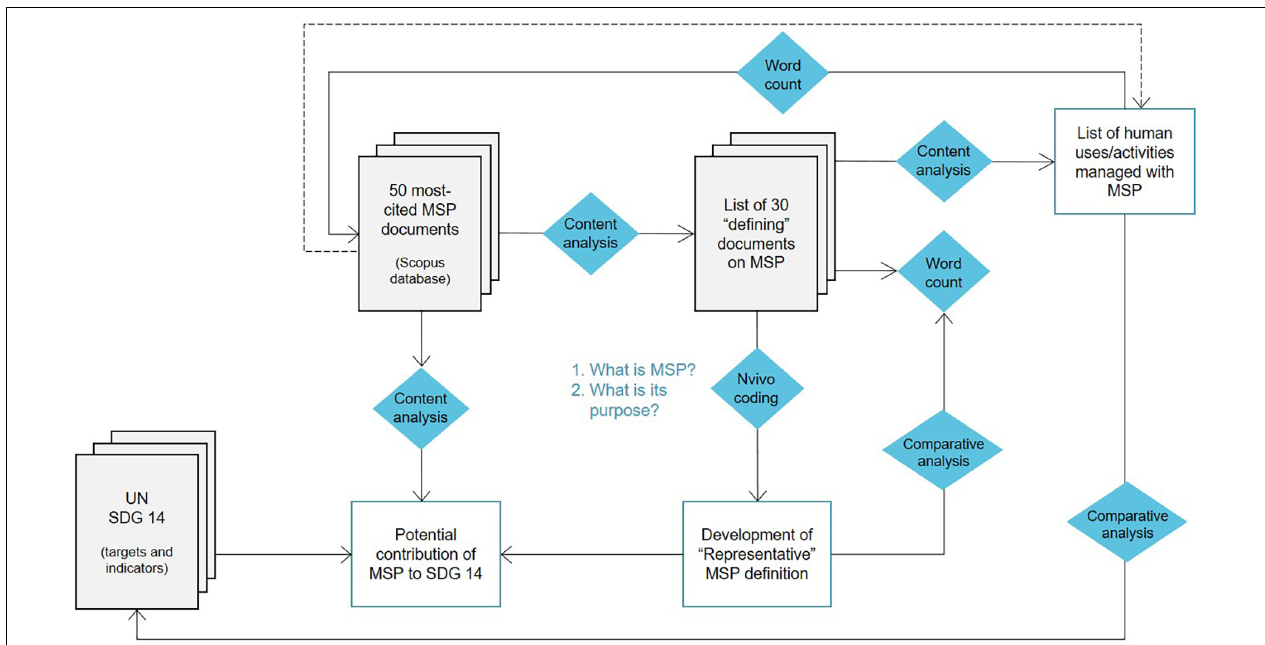
FIGURE 1 | Illustration of the methodological process used to establish a representative MSP definition, analyze human uses addressed in MSP, and investigate the contribution of MSP to each target of the SDG